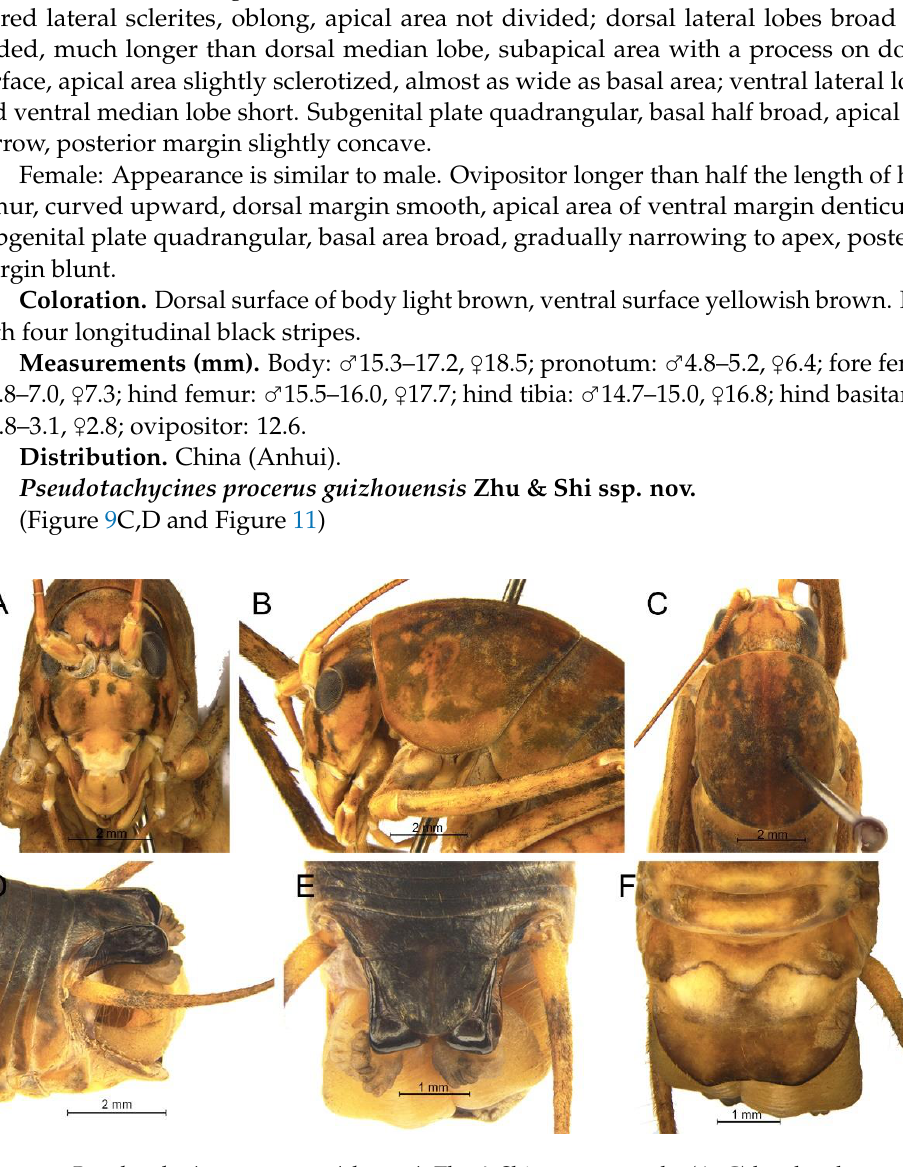
Figure 11. Pseudotachycines procerus guizhouensis Zhu & Shi ssp. nov., male: ( A – C ) head and pronotum: ( A ) frontal view, ( B ) lateral view, ( C ) dorsal view; ( D – F ) apex of abdomen: ( D ) lateral view, ( E ) dorsal view, ( F ) ventral view.